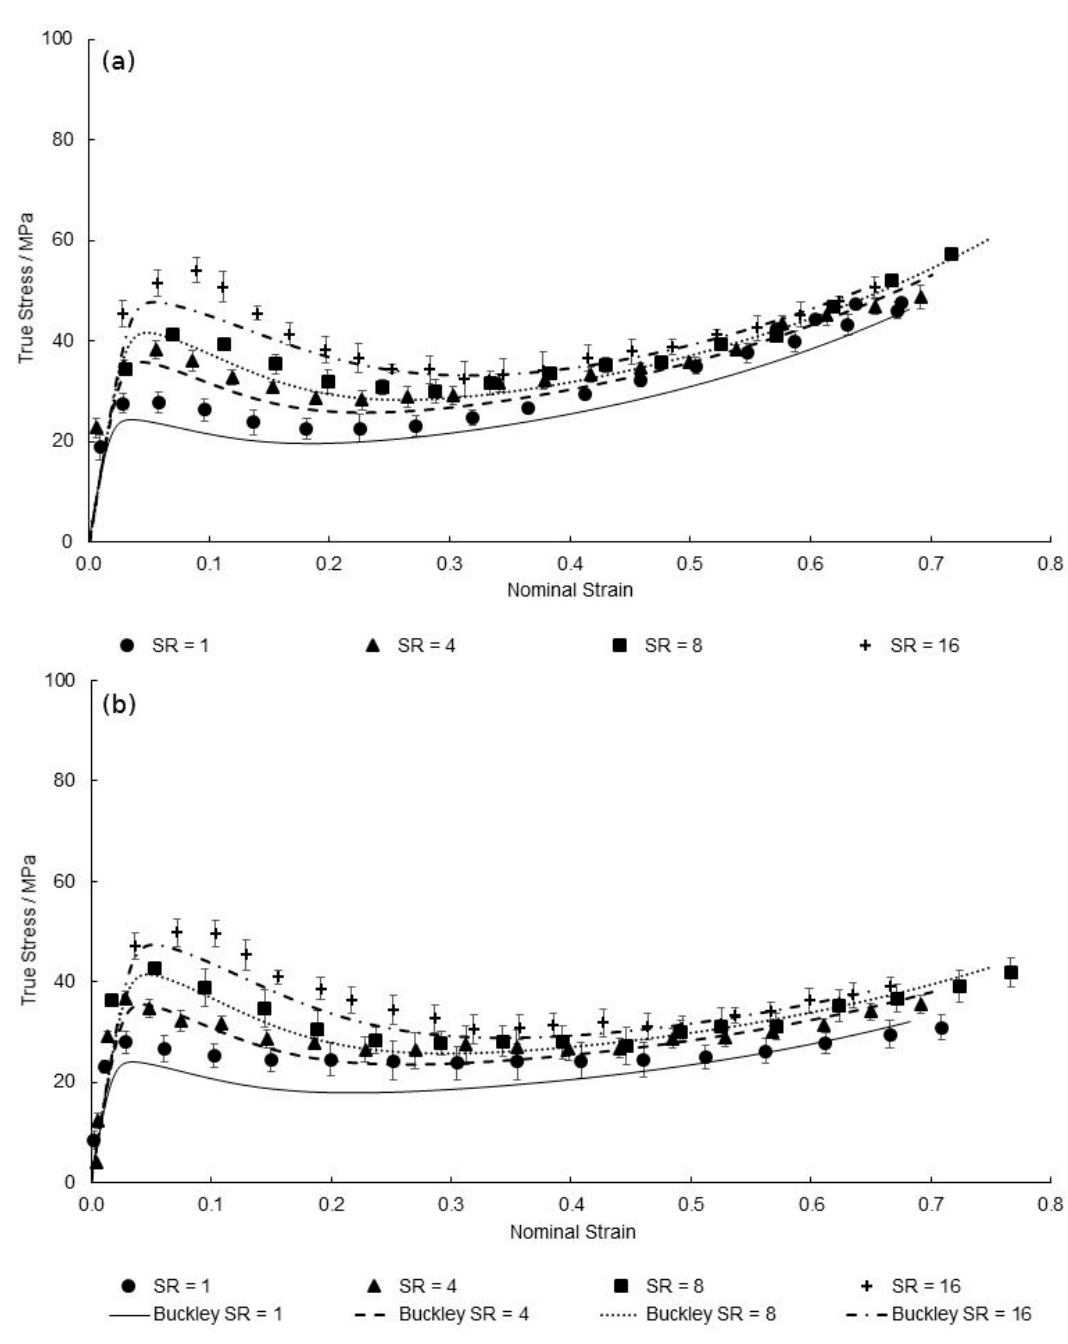
Figure 22. Predicted EB deformation behaviour by modified Buckley model for strain rates between 1 and 16 s − 1 , at a temperature of 140 °C in the ( a ) machine direction and ( b ) transverse direction.